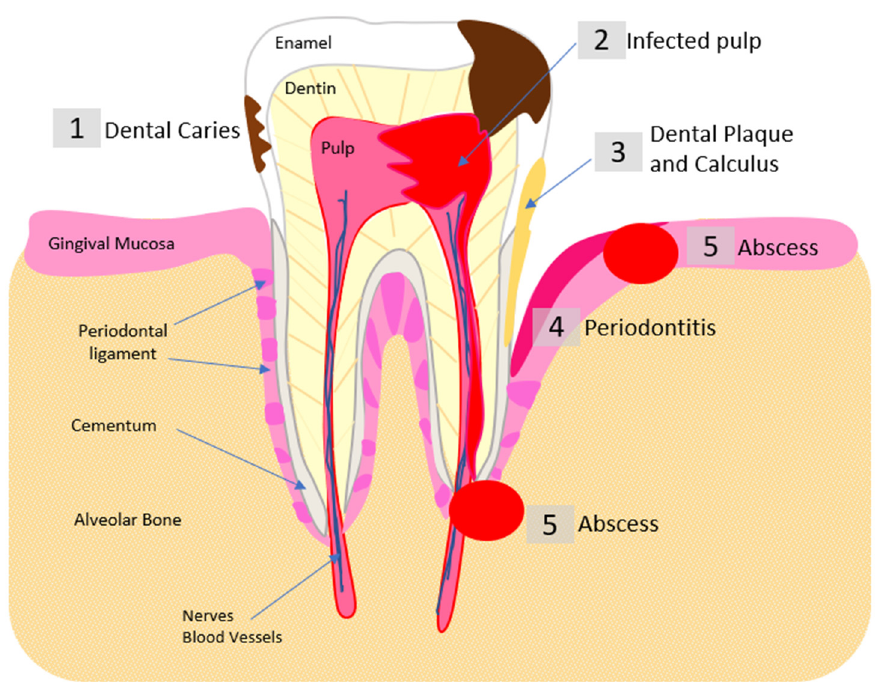
Figure 2. Localization of bacterial oral pathogenesis. (1) Dental Caries: tooth enamel dissolved by acid produced by specific bacteria (e.g., Mutans streptococci , Lactobacilli ). (2) Dental Pulp Infection: necrotic pulp tissues infected by microorganisms causing pulp inflammation and eventual necrosis. (3) Plaque and Calculus: biofilms form on non-shedding surfaces of the teeth; formation leads to caries and periodontal inflammation. (4) Periodontitis: dysbiotic bacterial infections cause inflammation that destroys periodontal ligament and bone. (5) Abscess: periodontal and periapical abscesses are pockets of pus caused by bacterial infection.